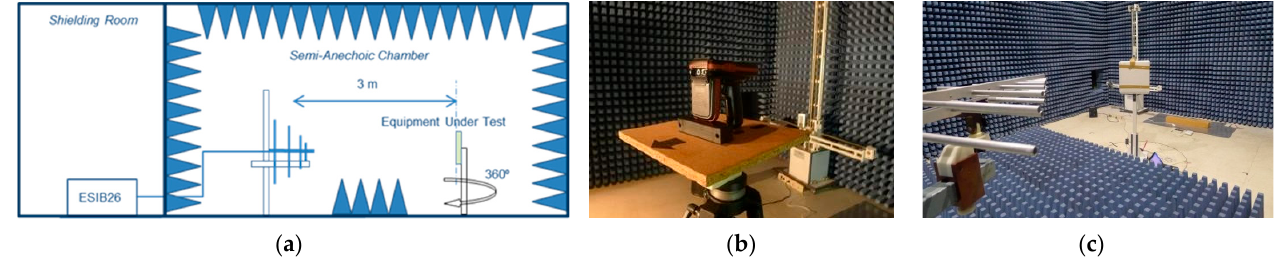
Figure 4. Laboratory measurements of the EMF emitted by RFID readers inside the anechoic chamber: ( a ) measurement scenario, ( b ) measurement of a MO-RFID reader, ( c ) measurements of AG-RFID reader.